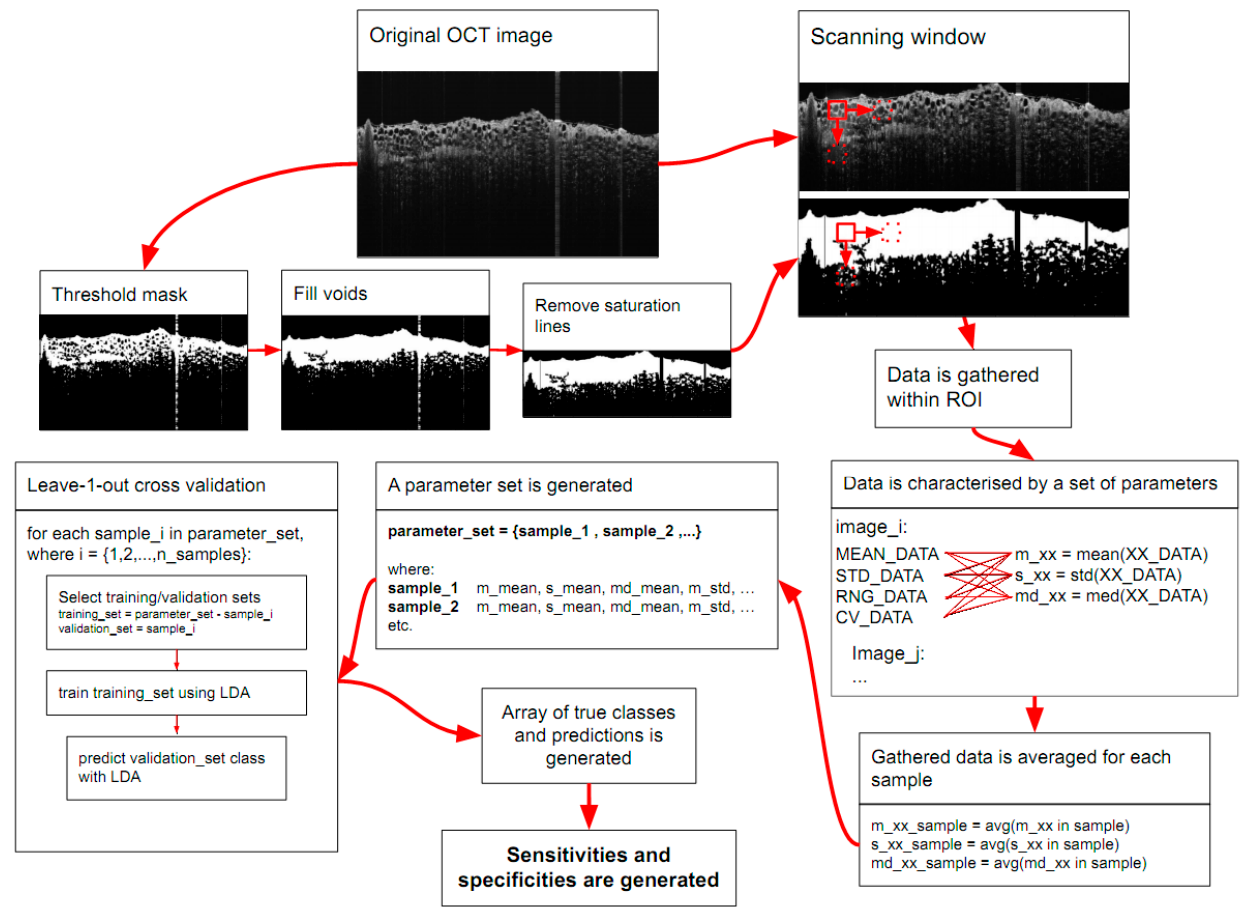
Figure 2. Representative image processing flowchart. An example of a difficult to mask image— lipoma (original OCT image scan region 6 × 3.5 mm). The tissue has many voids in it, and there are strong back reflection lines visible. A naive threshold mask shows why this is an issue. Saturation lines can be mistaken for tissue, and the voids in the tissue structure could be ignored. Hence, the voids were detected and filled, and reflection lines removed. The scanning window, schematically represented by the red square, is moved around within the masked region. The stride is set to 1 in the movement directions (which are indicated by the red arrows). The window looks at each pixel and its surrounding pixels; for a 15 × 15 pixel window, the window contains 225 values. These are then used to calculate μ , σ , intensity range, and CV parameters, and these are then added to an array for later processing. In total, 12 parameters from scanning window data were calculated for each image, then averaged for each sample. The resulting parameter set is used for leave-one-out cross-validation, which generates a table of true and predicted classes. From this, sensitivities and specificities are calculated for each class.